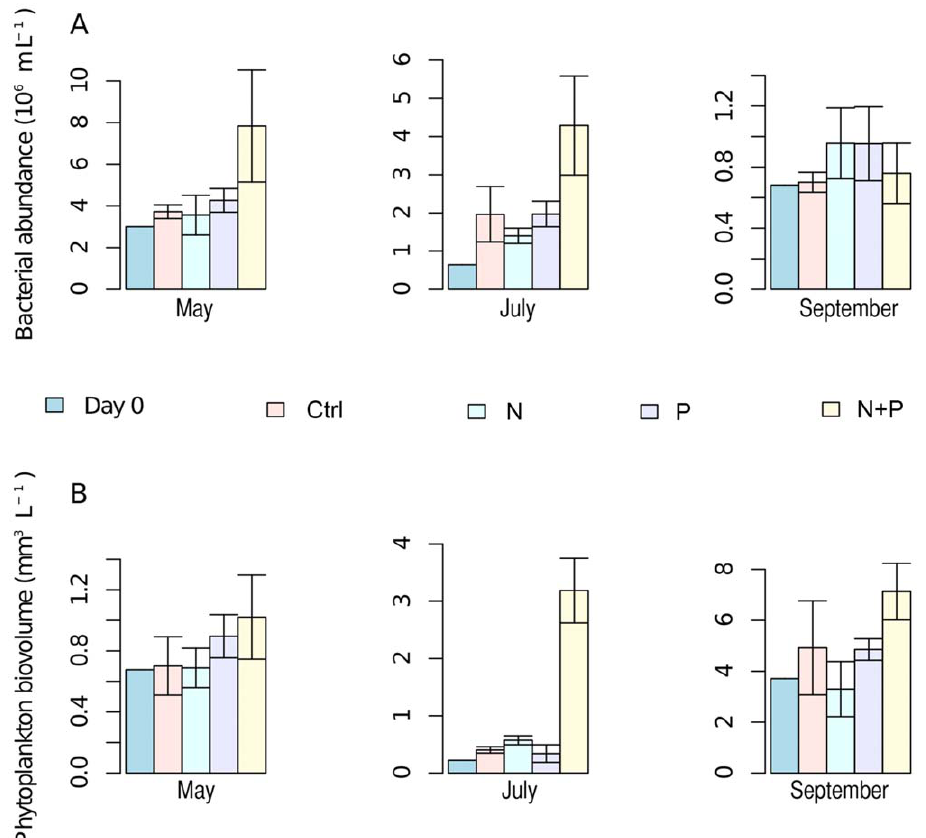
Figure 2. Bacterial abundance (A) and phytoplankton biovolume (B) at the start and at the end of the experiments. Note different Y- axis scales between the panels. In all panels n=1 for day 0 and n=4 for day 7. Error bars represent standard deviation.